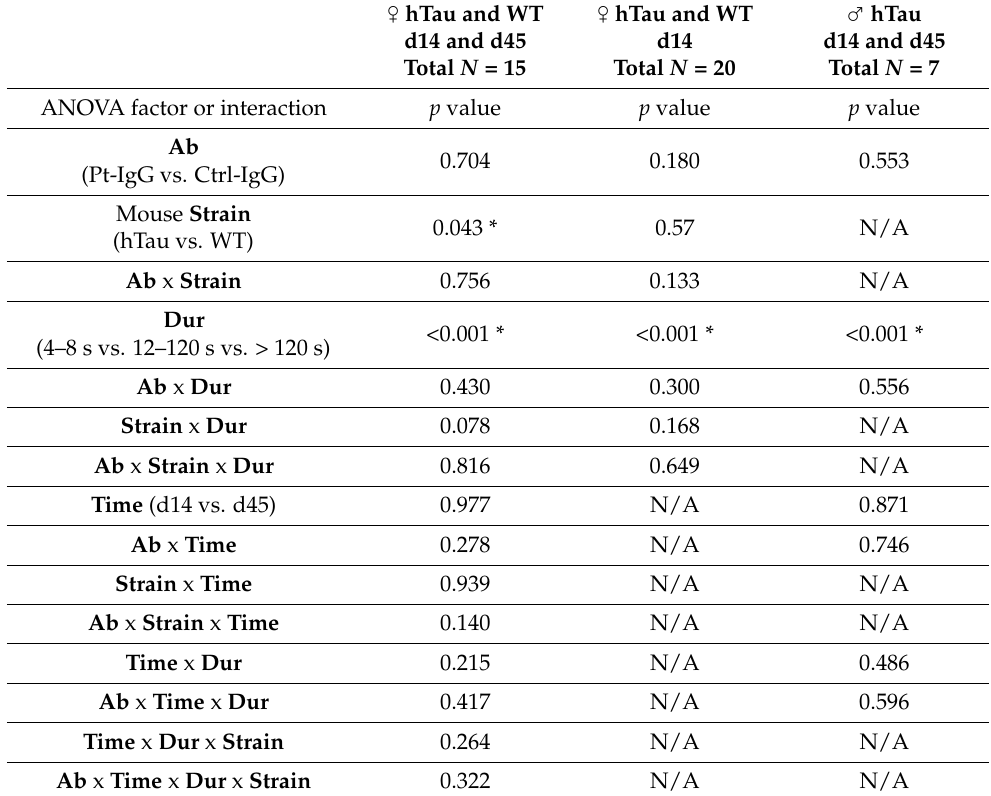
Table A5. Statistical analysis of NREM sleep bout duration.